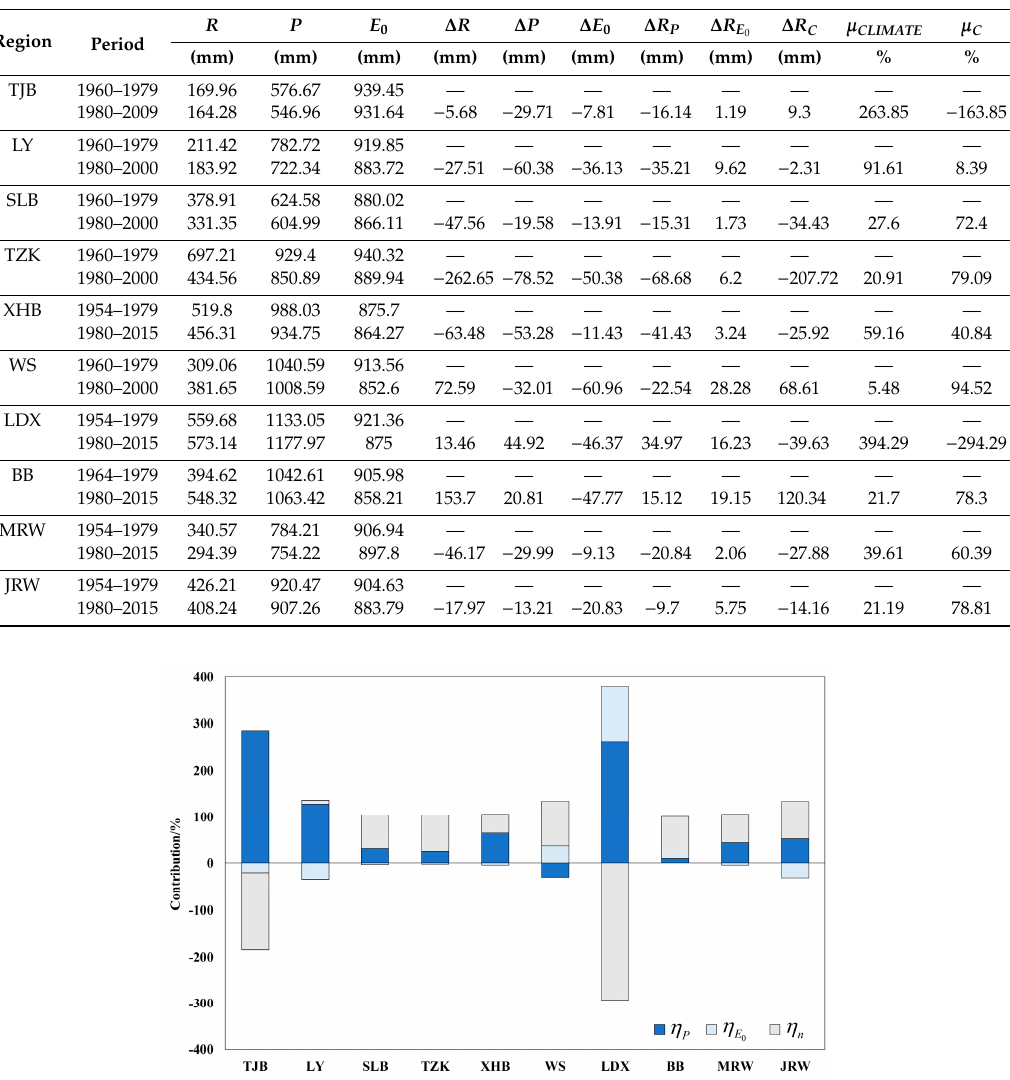
Table 3. Runo ff variation and attribution analysis for the Jialing River Basin.